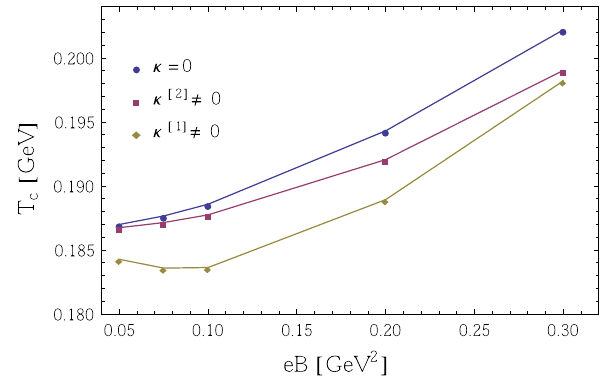
Fig. 6 The pseudocritical temperature for the chiral transition of mag- netized quark matter as a function of the magnetic field for fixed values of AMM κ